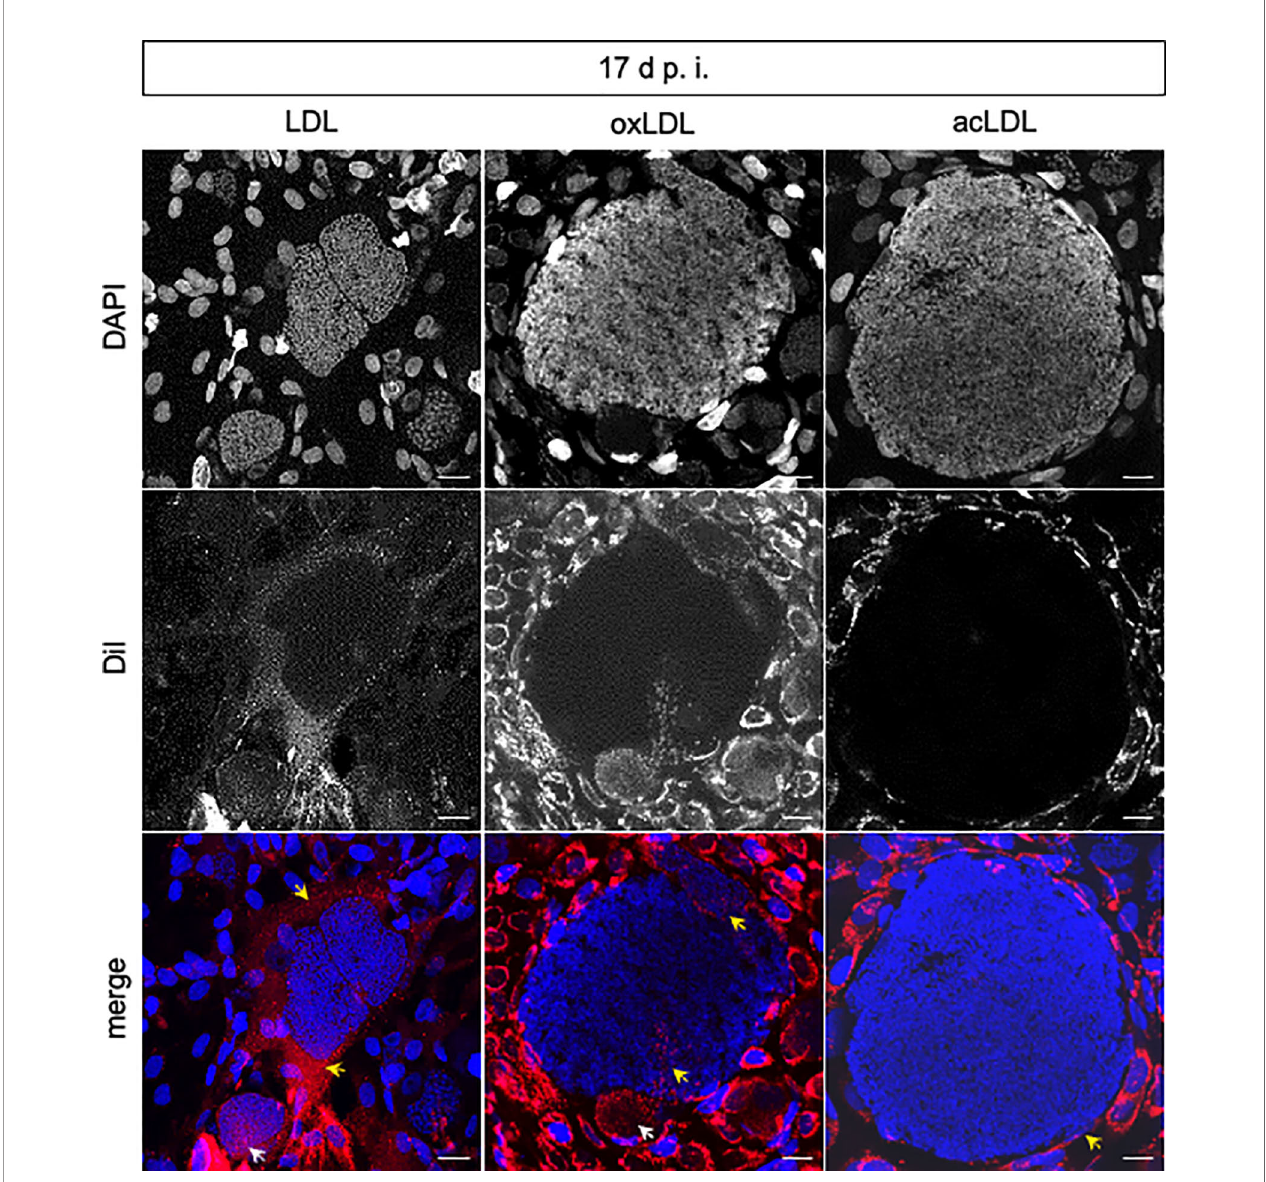
FIGURE 3 | Internalization of LDL, acLDL, and oxLDL by E. bovis -infected host endothelial cells and meronts I. Confocal analyses revealed that Dil-LDL, Dil-oxLDL, and Dil-acLDL (red) were internalized into the host cell cytoplasm at all time points studied ( n = 3, representative illustration). Intrameront LDL and oxLDL internalization (white arrows) was observed at 17 d p.i. In contrast, acLDL was not observed within meronts I. DAPI (blue) stained DNA. Internalization of marked lipids in the cytoplasm of host cells (LDL, oxLDL, acLDL) or stretches of the parasitophorous vacuole membrane (oxLDL) are signed with yellow arrows. Scale bar 20